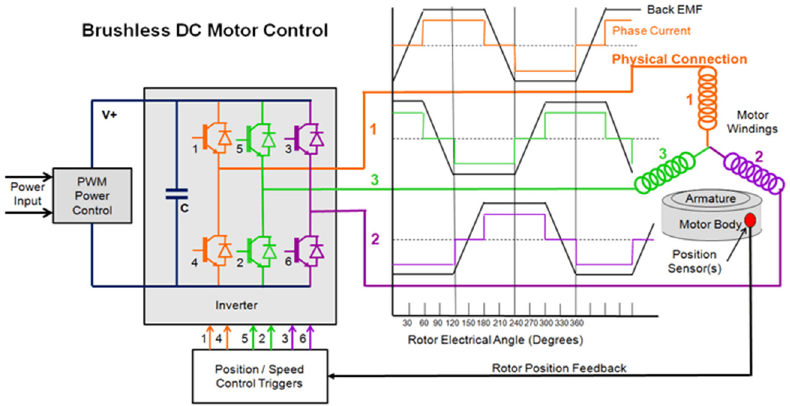
Figure 2. Control block diagram of the BLDC motor.